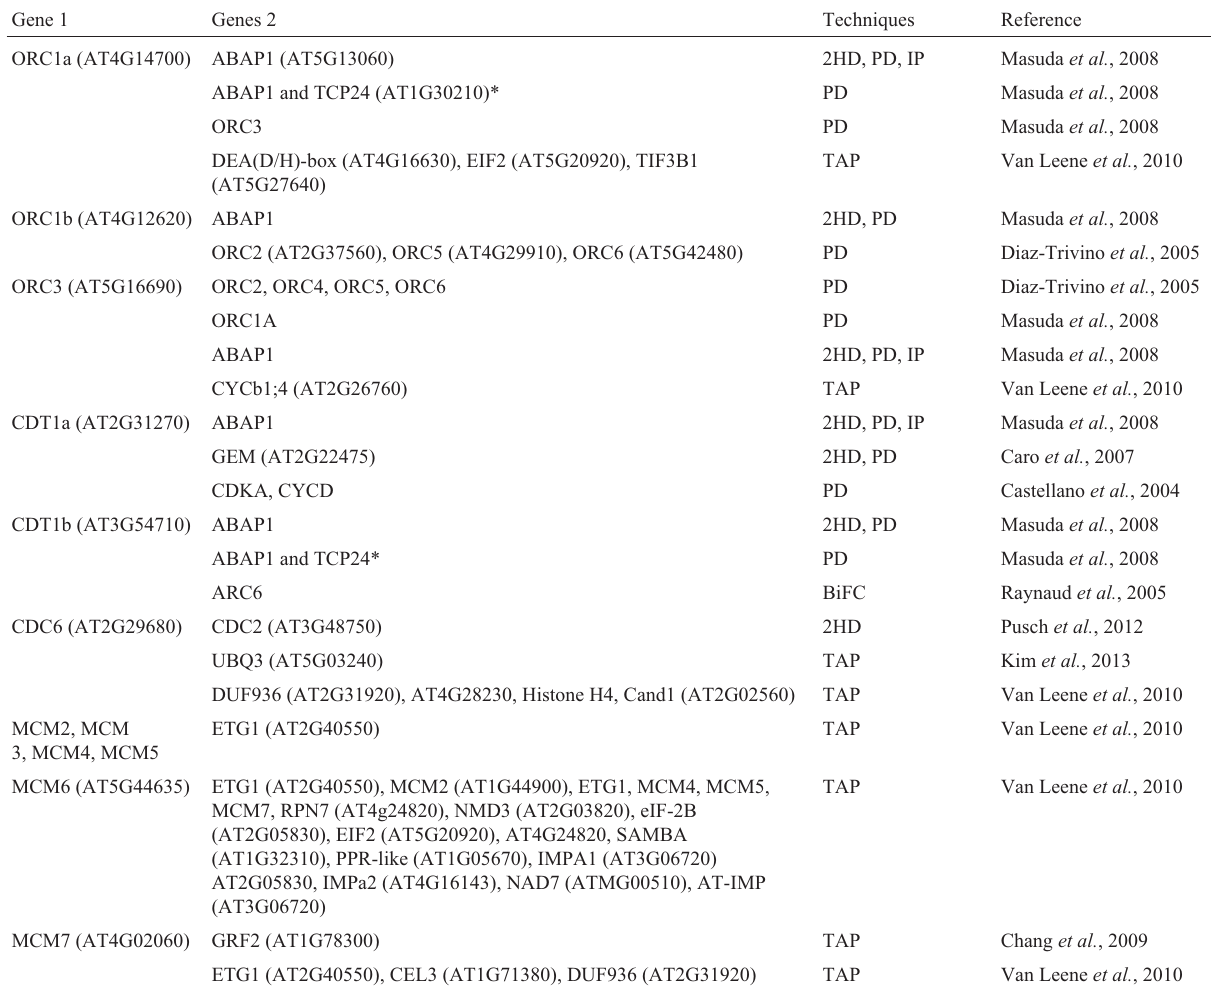
Table 2 - Pre-replication complex (pre-RC) protein interactions observed in experimental analysis in A. thaliana . Techniques: 2HD: yeast two-hybrid PD: pull-down; IP: immuno-precipitation; TAP: tandem affinity